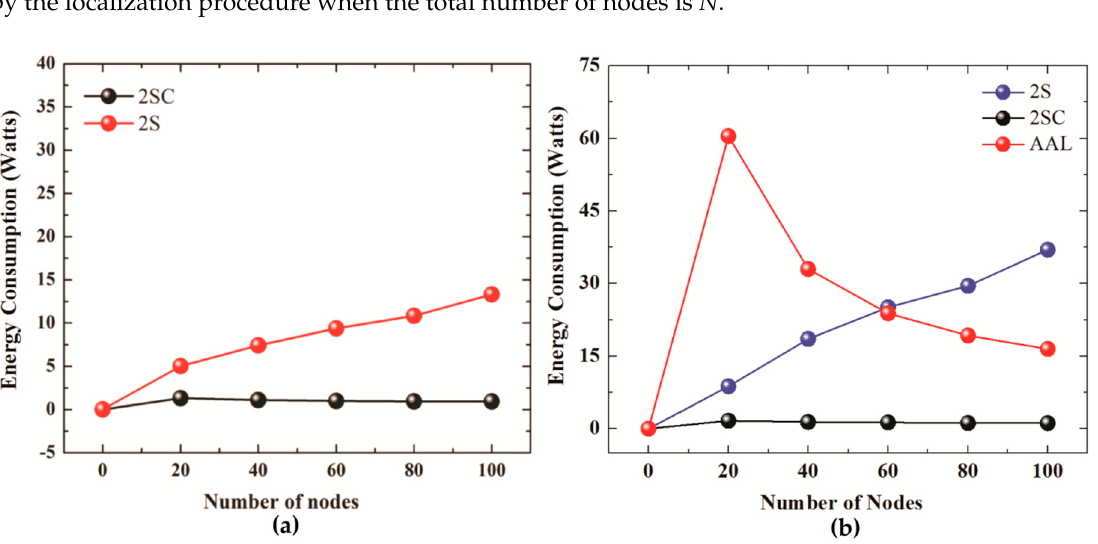
Figure 8. ( a ) Energy Consumption for No. of iterations = 2. ( b ) Energy Efficiency for No. of iterations = 3 (2S, 2SC), AUV Aided Localization.